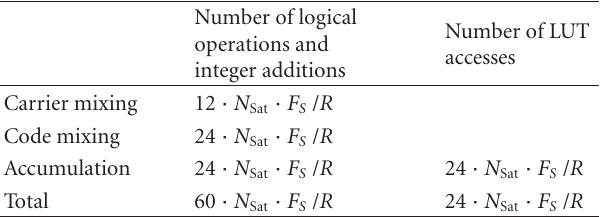
Table 4: Amount of operations per second necessary to process N Sat satellites with the distributed